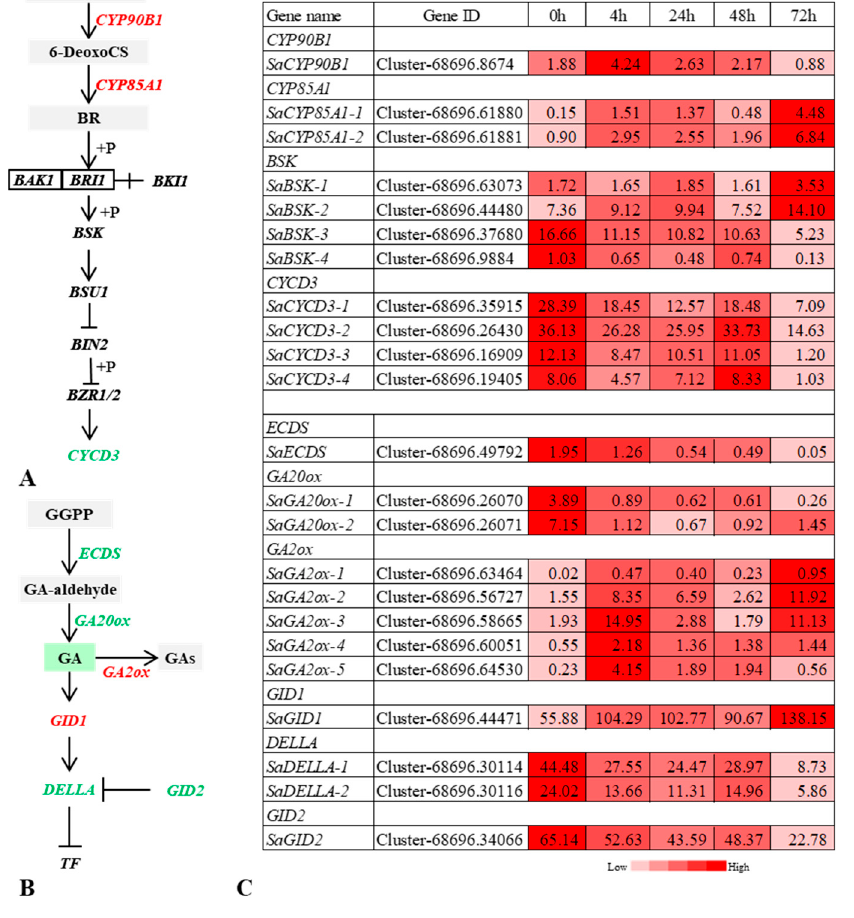
Figure 6. Overview of the relationship between differentially expressed genes (DEGs) and differential metabolites (DMs) in the BR and gibberellin (GA) signaling pathway of Sophora alopecuroides under salt stress. ( A ) Overview of BR signaling pathway. ( B ) Overview of GA signaling pathway. ( C ) Heat map of CK and GA signaling pathway-related gene expression. Values are average FPKM value of each sample in each group. BRs, brassinosteroids; BSK, BR-signaling kinase; CR, campesterol; CYCD3, cyclin D3; CKs, cytokinins; DELLA, DELLA protein; GA20ox, gibberellin 20-oxidase; GA2ox, gibberellin 2-oxidase; GGPP, geranglgeranyl-PP; GID1, gibberellin receptor GID1; GID2, F-box protein